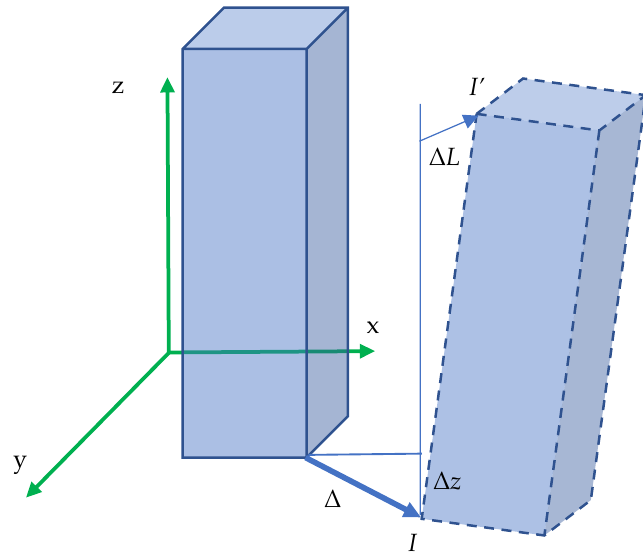
Figure 15. Total displacements of the structure and its roll.